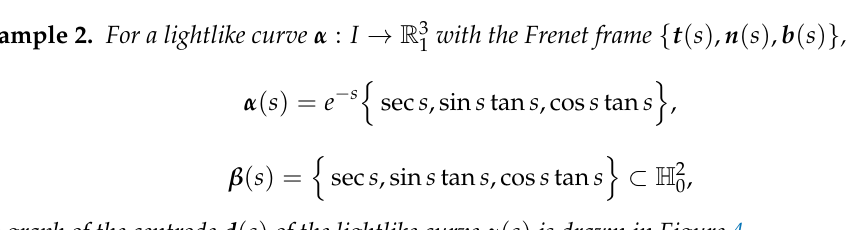
Figure 3. the lightlike curve (black curve) and its centrode (red curve).